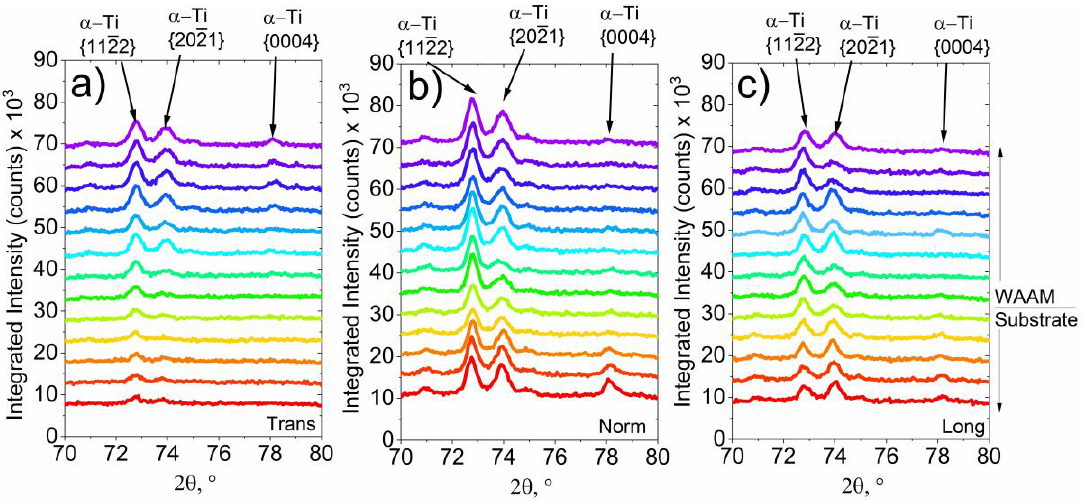
Figure 9. Di ff ractograms along the N-line for ( a ) transversal component, ( b ) normal component, ( c ) longitudinal component.